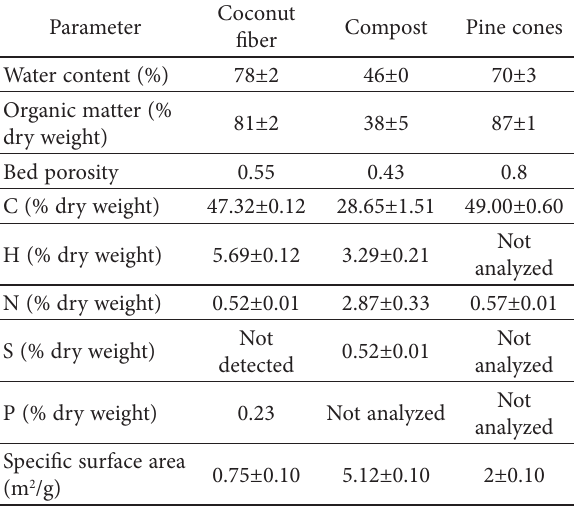
Table 1. Initial characteristics of biofilters and organic packing materials